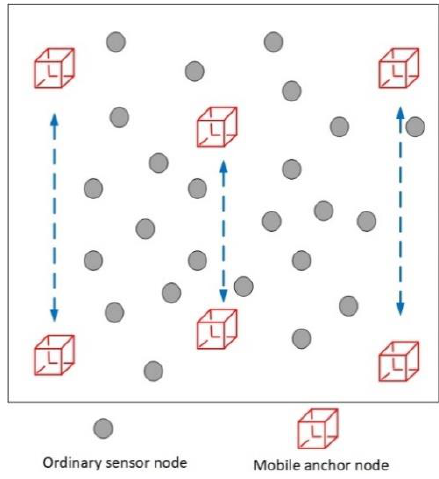
Figure 2. The vertical plane of the 3D UWSNs.